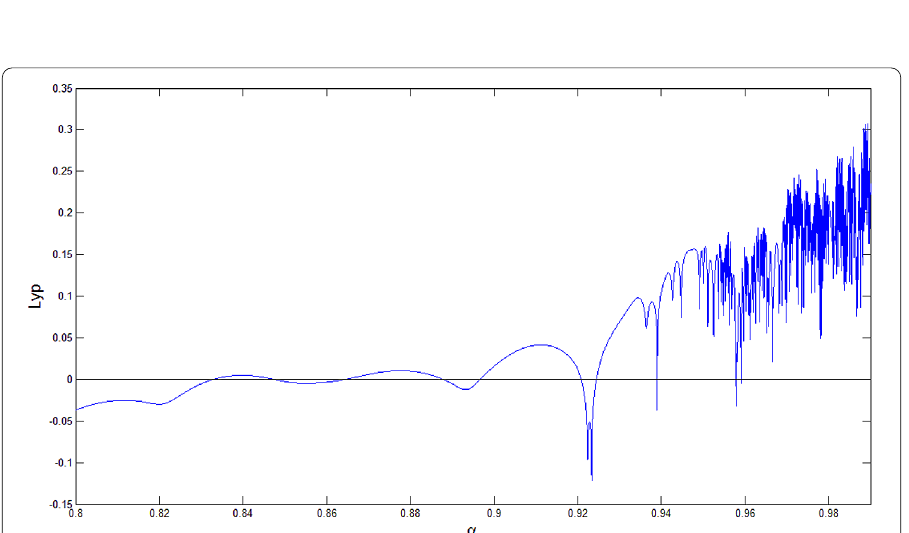
Figure 6 Maximal Lyapunov exponents corresponding to Figure 4